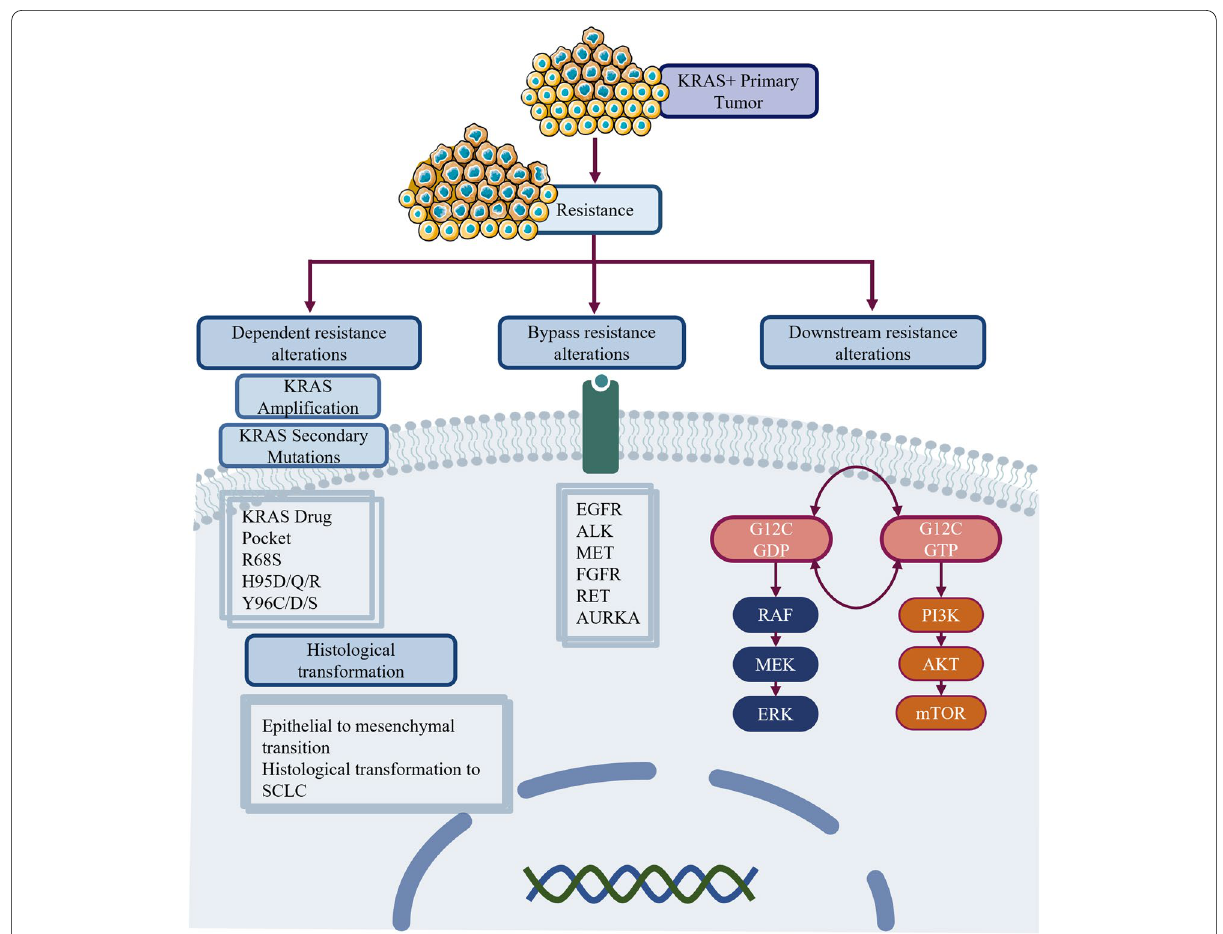
Fig. 3 Resistance mechanisms of KRAS TKIs. Acquired resistance mechanisms to KRAS targeted therapies in NSCLC can be mainly divided into KRAS-dependent and KRAS-independent resistance mechanisms. KRAS-dependent resistance mechanisms include KRAS amplification and KRAS secondary mutations. KRAS-independent resistance mechanisms include bypass resistance alterations, downstream resistance alterations, and histological transformation. EGFR, ALK, MET, FGFR, RET, and AURKA are identified as bypass pathway resistance alterations. In addition, mutations of BRAF, MEK, mTOR, and JAK are identified as downstream pathway resistance alterations. With regard to histological transformation, it was reported cases related with EMT, and histological transformation to SCLC. KRAS, Kirsten rat sarcoma virus; TKIs, tyrosine kinase inhibitors; EGFR, epidermal growth factor receptor; ALK, anaplastic lymphoma kinase; MET, hepatocyte growth factor receptor; FGFR, fibroblast growth factor receptor; RET, proto-oncogene tyrosine-protein kinase receptor Ret; BRAF, V-raf murine sarcoma oncogene homolog B1; mTOR, mechanistic target of rapamycin; JAK, Janus kinase; EMT, epithelial to mesenchymal transition; SCLC, small cell lung